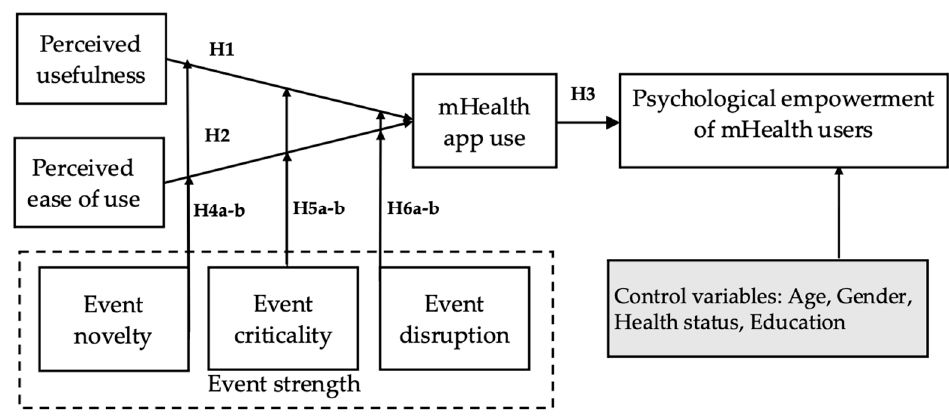
Figure 1. Research